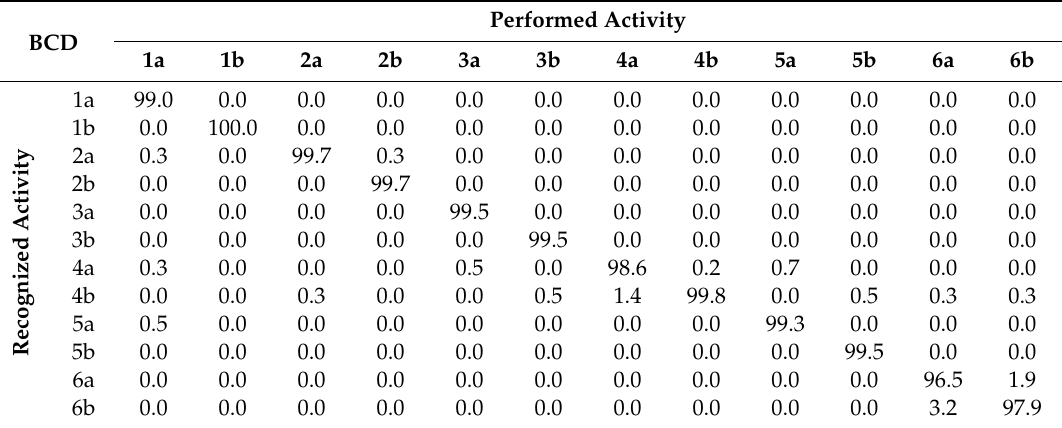
Table A7. Matrix of recognition errors (in %) of 12 motor activities 1a ÷ 6b in test set for all volunteers together for sensor BCD.